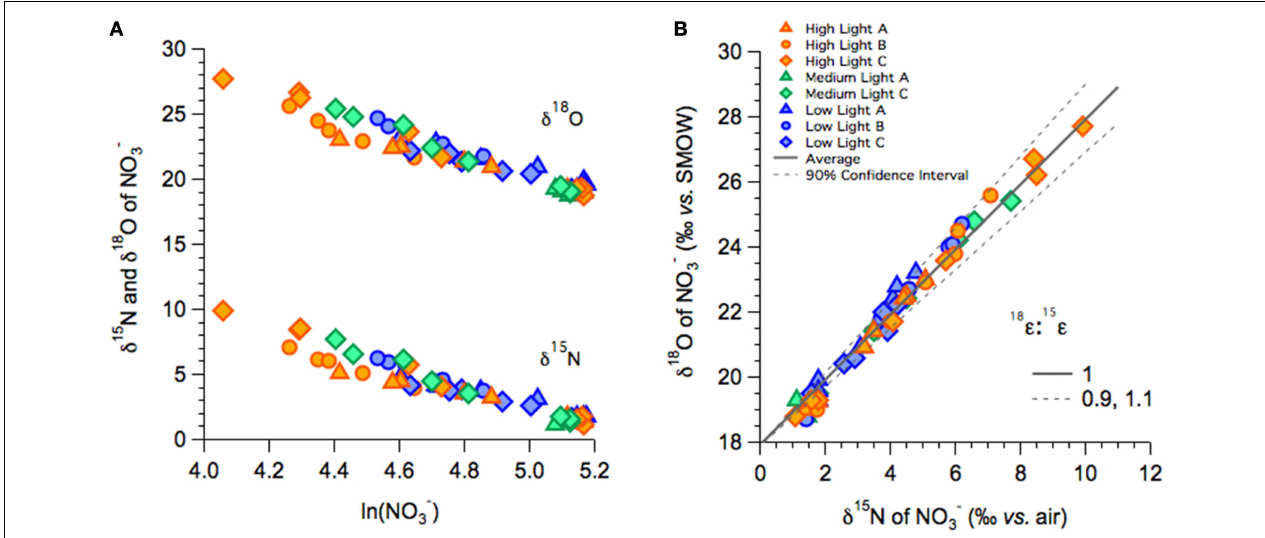
FIGURE 3 | NO − 3 isotope dynamics of fall incubations: (A) NO − 3 δ 15 N plotted vs. the logarithm of the NO − 3 remaining for the high-, medium-, and low-light treatments. The respective slopes of the linear relationships approximate 15 ε . (B) δ 18 O vs. δ 15 N of NO − 3 for the high-, medium-, and low-light treatments.